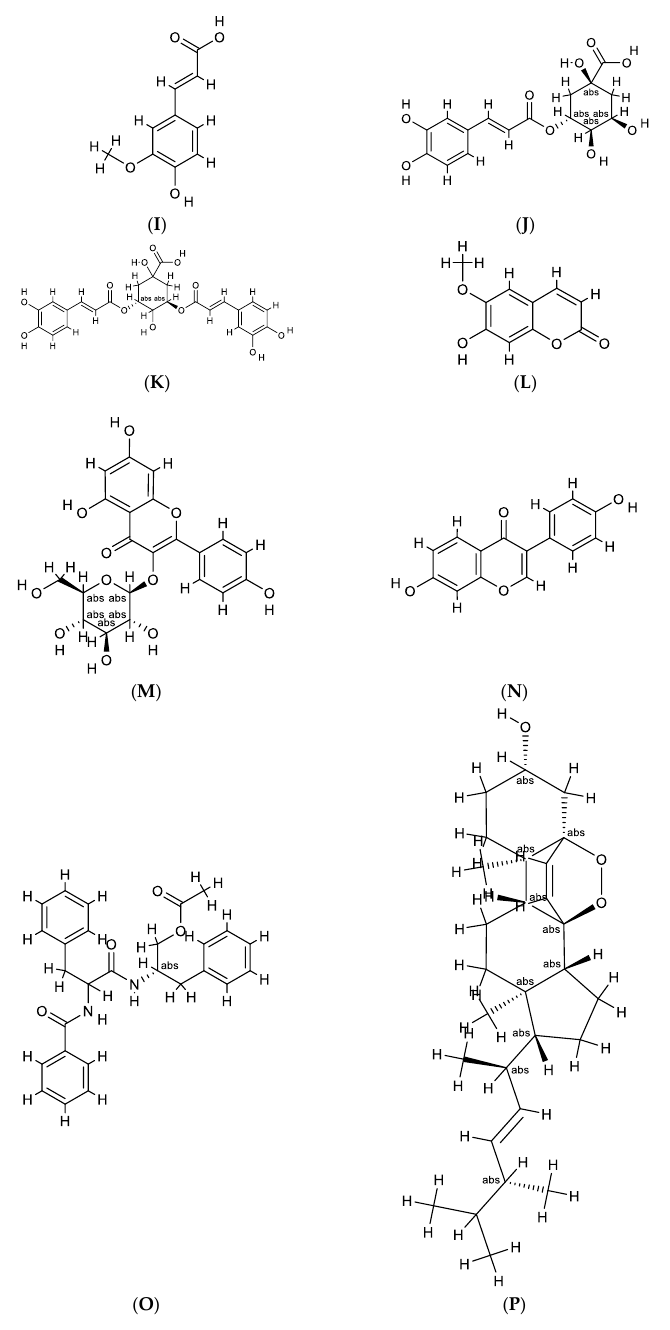
Figure 3. Chemical structure of the principal chemical compounds in Miwu. ( A ) Z-Ligustilide. ( B ) Sedanolide. ( C ) Senkyunolide-E. ( D ) Z-3-Butylidene phthalide. ( E ) Senkyunolide H. ( F ) Tetra- methylpyrazine. ( G ) N-Hexadecanoic acid. ( H ) Tetradecanoic acid. ( I ) Ferulic acid. ( J ) Chlorogenic acid. ( K ) 3,5-Dicaffeoyl quinic acid. ( L ) Scopoletin. ( M ) Astragalin. ( N ) Daidzein. ( O ) Aurantiamide acetate. ( P ) Ergosterol peroxide.